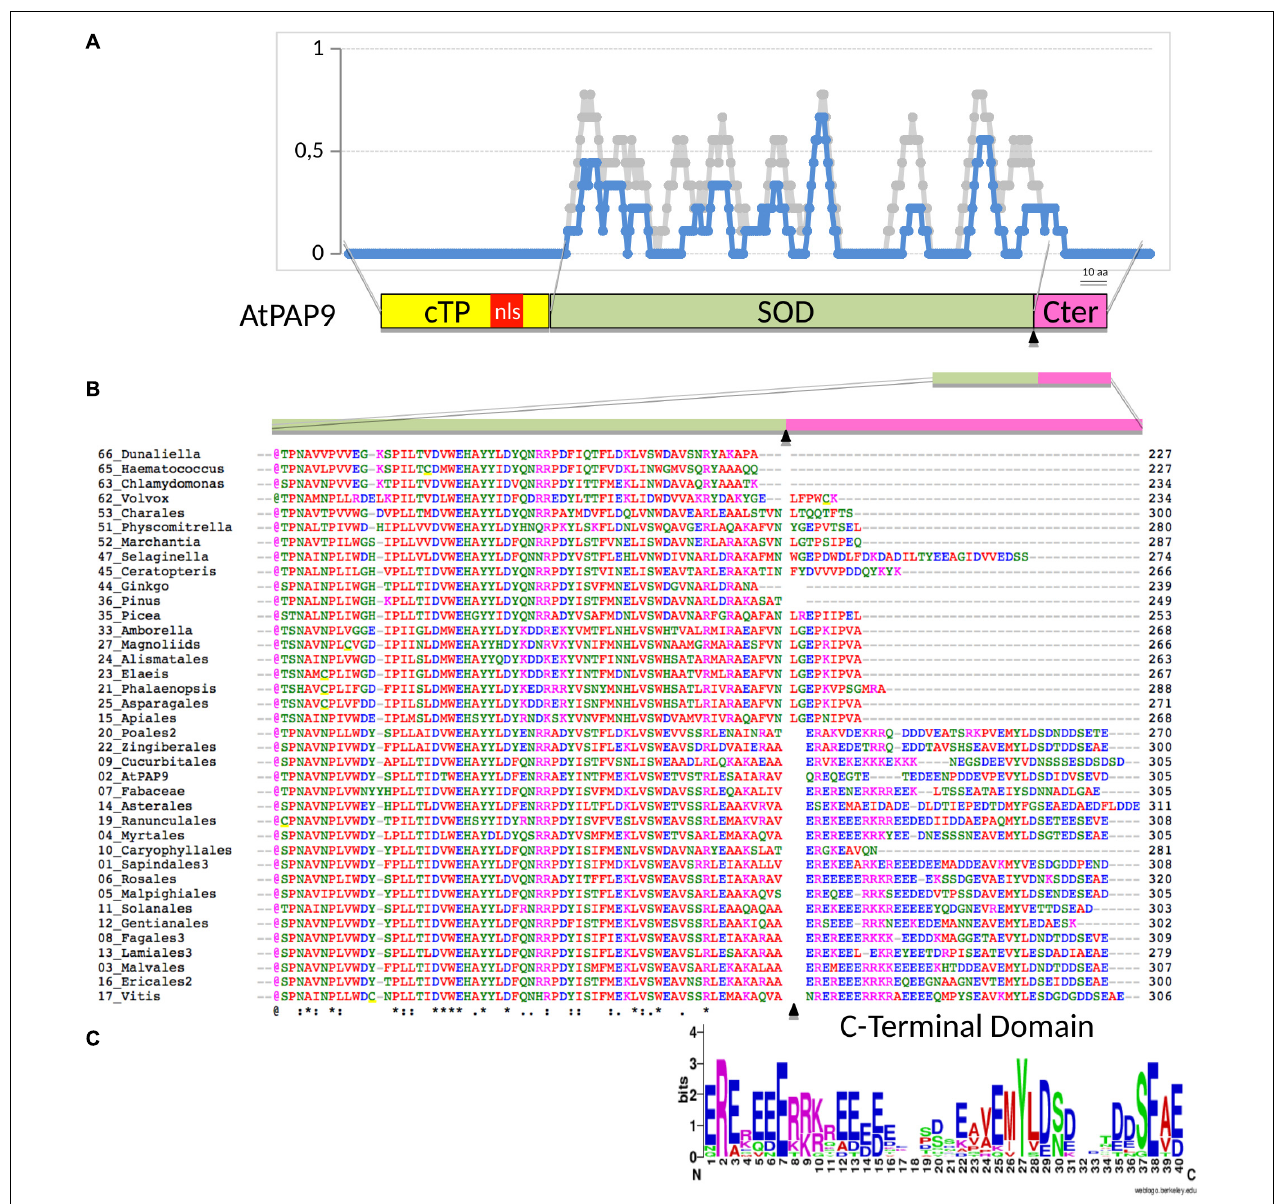
FIGURE 2 | Sequence alignment of predicted orthologous PAP9 protein found in representatives of phylogenetic clades as described in Supplementary Table 1 . (A) Amino acid identity (in blue) and similarity (in light gray) given in a 10-aa moving ratio. The alignment corresponds to the full dataset given in Supplementary Table 2 marked with a cross (column named in this figure). Schematic illustration of the PAP9 domains: cTP, chloroplast transit peptide in yellow; NLS, predicted nuclear localization signal in red; SOD, superoxide dismutase domain in khaki; C-terminal domain in magenta. (B) Amino acid partial alignment of the accessions as above, the 2-digit number corresponds to the clade given in Supplementary Table 1 . cTP, transit peptide as predicted with ChloroP1.1 (www.cbs.dtu.dk) underlined in yellow and described in Supplementary Table 3 . (*), (:), or (.), conserved, strongly similar or weakly similar amino acid properties (standards